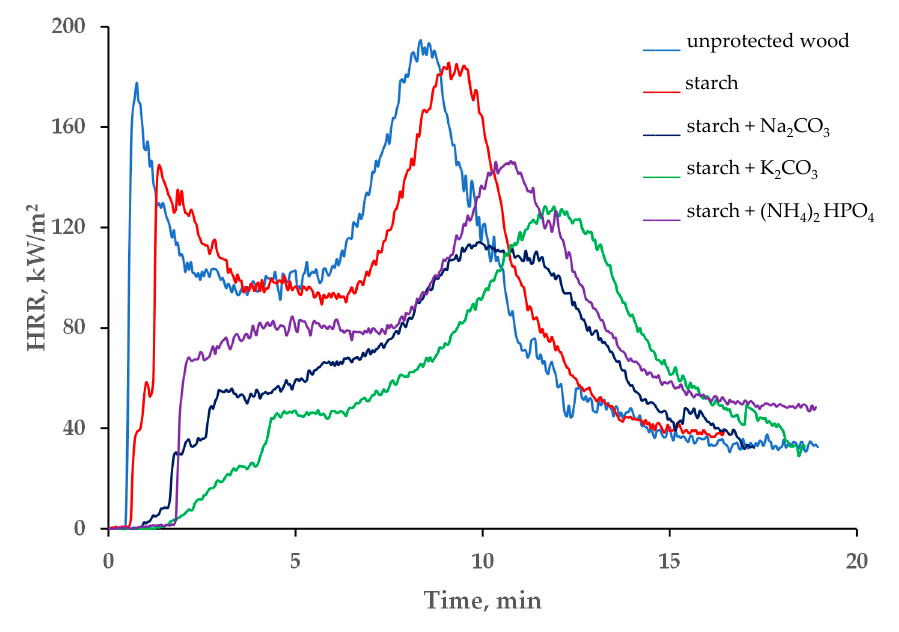
Figure 4. The HRR vs. time profiles of unprotected wood and the wood coated with starch-based